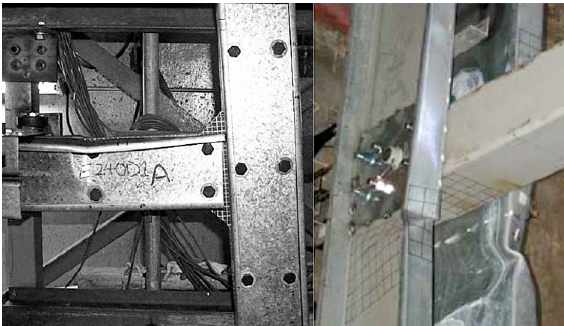
Fig. 7. Local buckling in beam and column sections (Uang et al. 2010; Wong, Chung